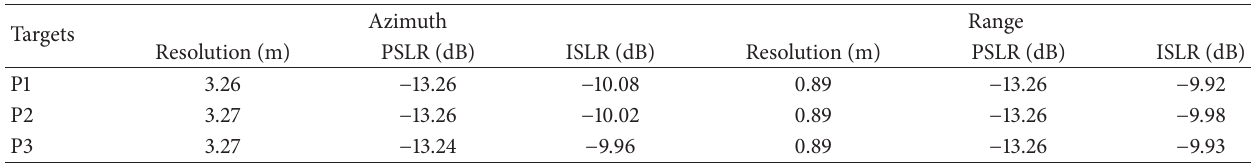
Table 2: Imaging parameters of simulated point